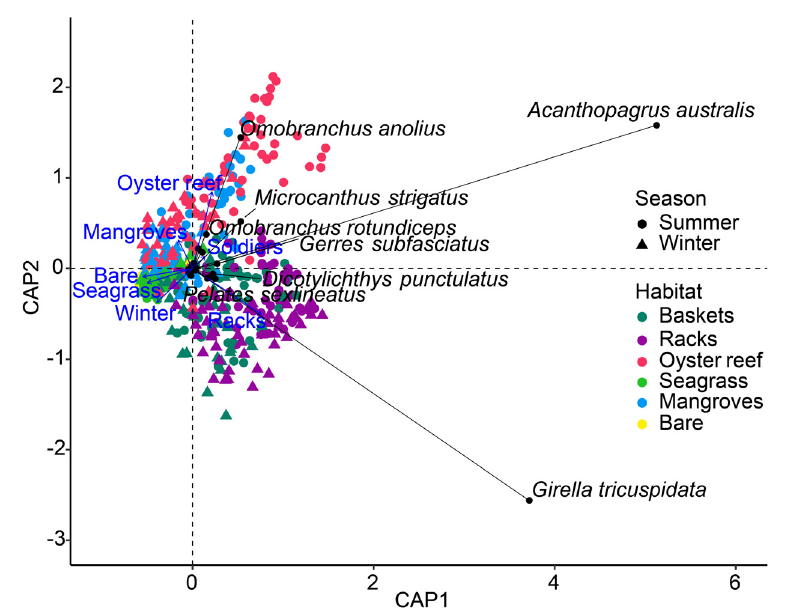
Fig. 3. Distance-based redundancy analysis triplot of transformed fish obser- vations data across 4 habitats, sites and seasons. Species exceeding a critical value of ±0.5 on one of canonical axes CAP1 and CAP2 axes are indicated. Points represent individual